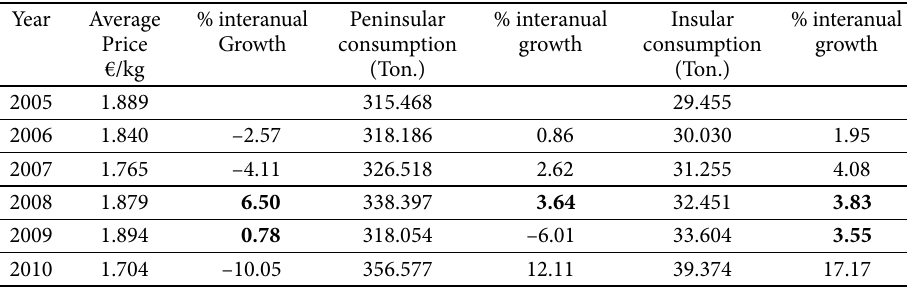
Table 7. Evolution of prices and consumption of bananas in Spain (Peninsula and Canary Islands)